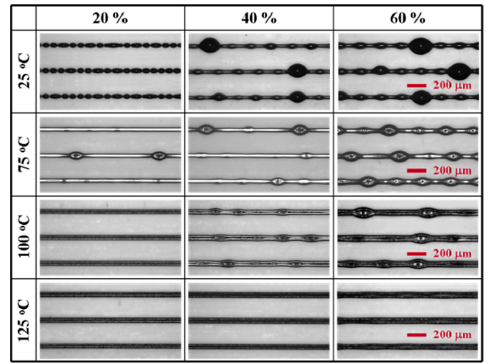
Figure 10. Microscopic images of inkjet-printed lines with 200 Hz printing frequency on S 50 substrate for various droplet overlaps and substrate temperatures.